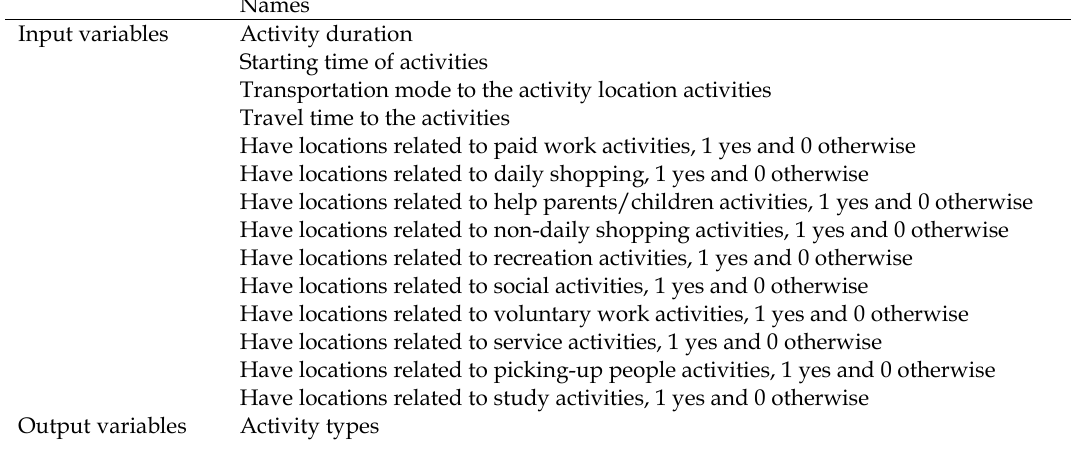
Table 2. Variables used in the imputation